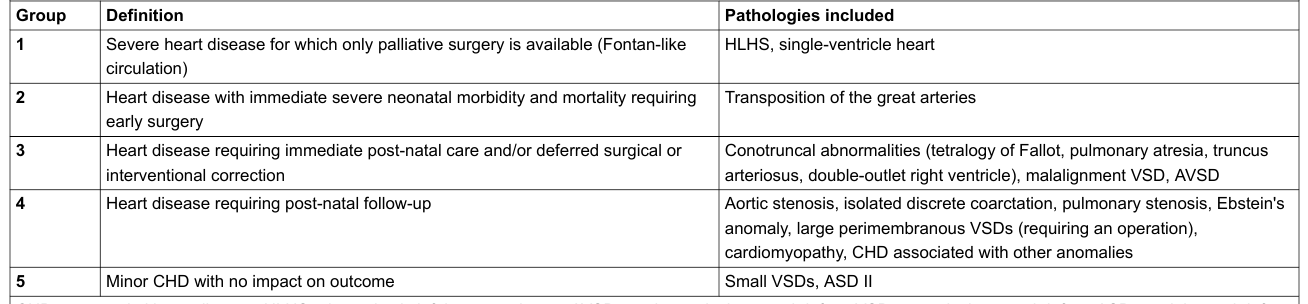
Table 1: Groups 1–5 were based on the type and severity of CHD. The category definition and associated pathologies in each group are provided.